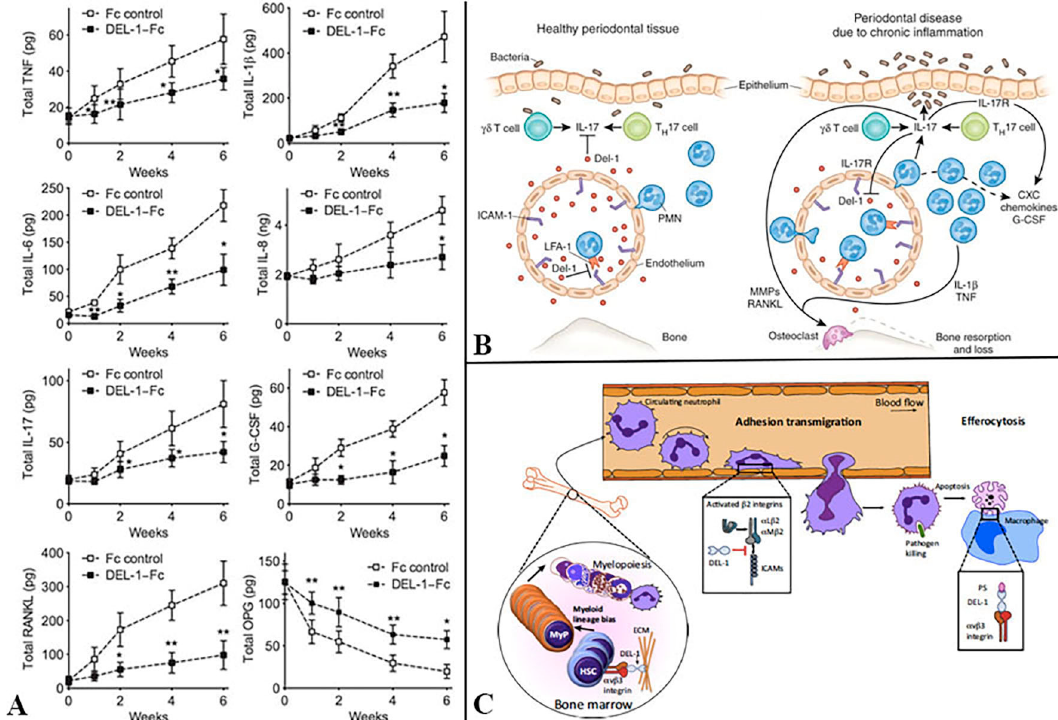
Figure 4. Reports about Del-1: ( A ) Shin et al. reported inferior amounts of pro-inflammatory cytokines of Del-1–Fc-treated monkeys. Cytokine analysis of GCF showed that Del-1–Fc treatment resulted in significantly lower levels of proinflammatory cytokines, whereas OPG, was sustained at higher levels in Del-1–Fc-treated sites [134]. ( B ) Diagrammatic illustration by Khader showing healthy periodontal tissue and diseases state. A higher expression of Del-1 in young mice hinders IL-17 synthesis and neutrophil trafficking, whereas, in older mice, Del-1 expression is downregulated and IL-17 production by γδ T cells, CD4 + T cells, and neutrophils is upregulated. IL-17 induces G-CSF and CXC chemokines to attract neutrophils into the inflamed tissue [135] ( C ) Hajishengallis and Chavakis reported that Del-1 interacts with β 3 integrin on hematopoietic stem cells (HSCs) and induces HSC proliferation and biased differentiation toward the myeloid lineage (MyP, myeloid progenitors). In the vessel lumen, Del-1 blocks the interaction between LFA-1 (aLb2) integrin on neutrophils and ICAM-1 on the vascular endothelium, thereby inhibiting neutrophil adhesion and transmigration. Ddl-1 can also block Mac-1 (aMb2) integrin, which mediates intraluminal crawling of neutrophils, although whether Del-1 inhibits crawling has not been specifically addressed [136]. All images adapted with kind permission from the publisher.